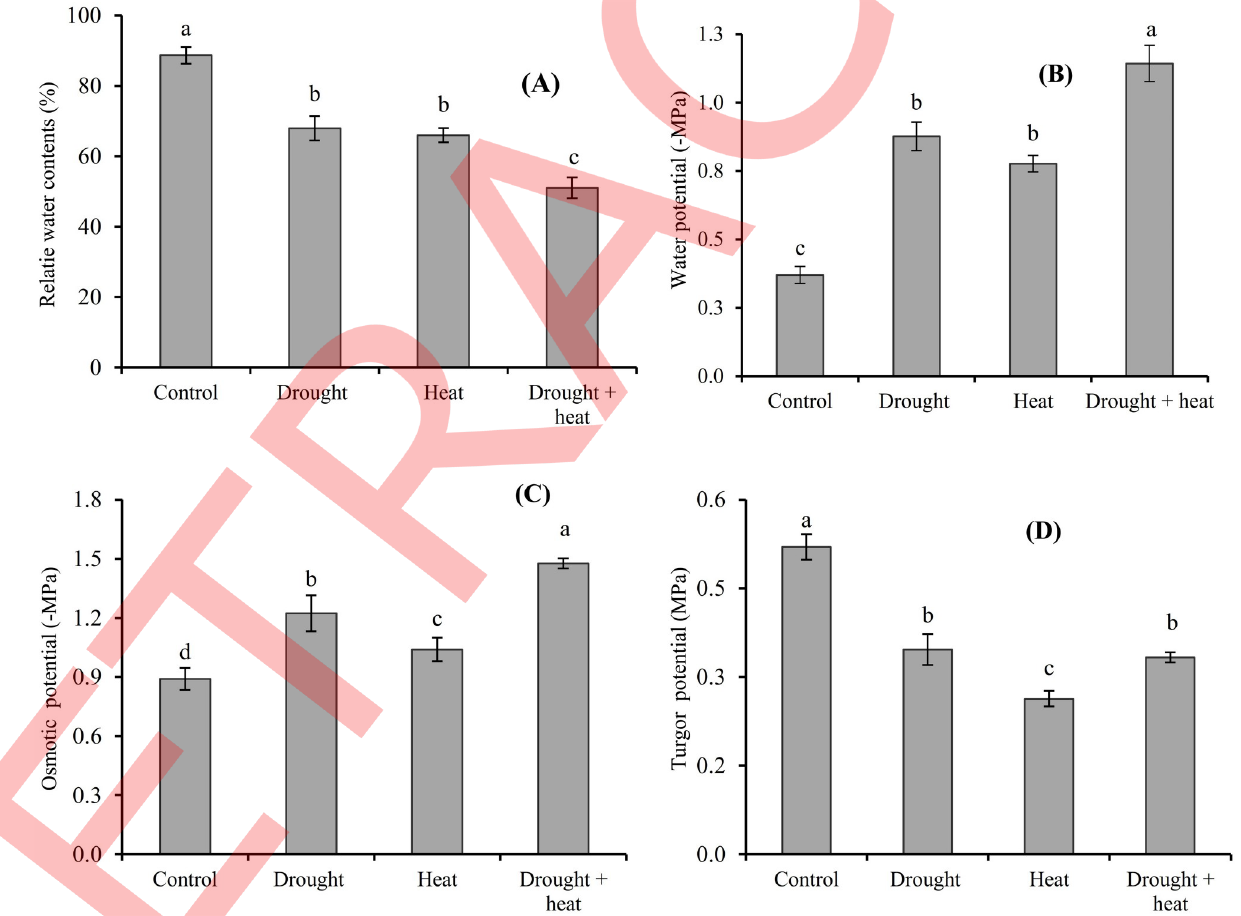
Fig 2. Effects of different drought and heat treatments on relative water content (A), Water potential (B), Osmotic potential (C) and Turgor Potential (D) of wheat. Values shows mean ± SE (n = 3). Bars sharing the same letters are statistically at par with each other at significance level of 5% ( P �